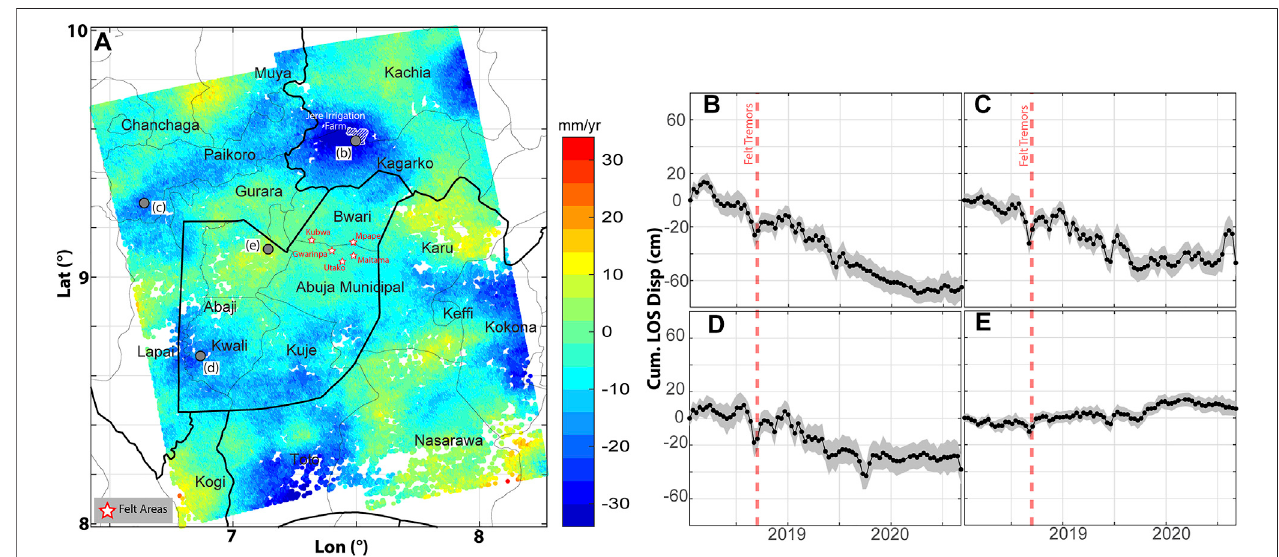
FIGURE 7 | InSAR deformation map obtained from Sentinel-1A/B ascending orbit (heading ∼ 347 ° and incidence angle ∼ 38.5 ° ) SAR images for period 2018/01/ 19 – 2020/09/05. (A) LOSlinearvelocity.Colder colorsindicatemovementawayfrom satelliteor subsidence. Blackpolygonsshowadministrativedivisions. (B) – (E) Time series of LOS displacement at four locations shown in panel (A) . The gray shading indicates a 1-sigma uncertainty range for the estimated time series.